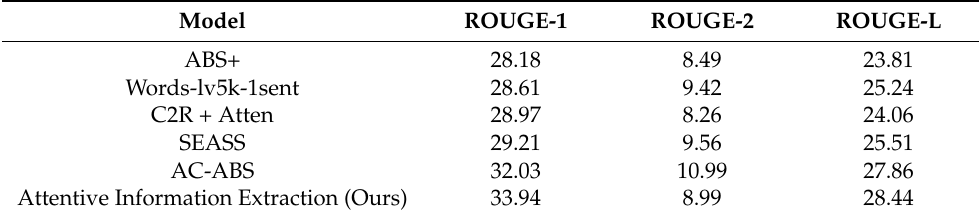
Table 5. ROUGE recall on DUC-2004. All our ROUGE scores have a 95% confidence interval in the official ROUGE